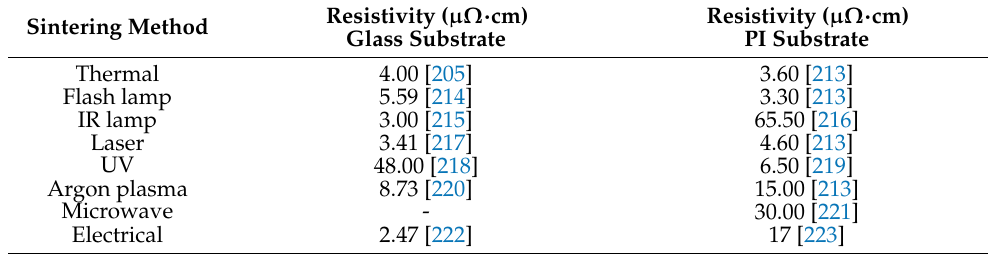
Table 6. Comparison of different sintering methods for nanosilver ink on glass and PI